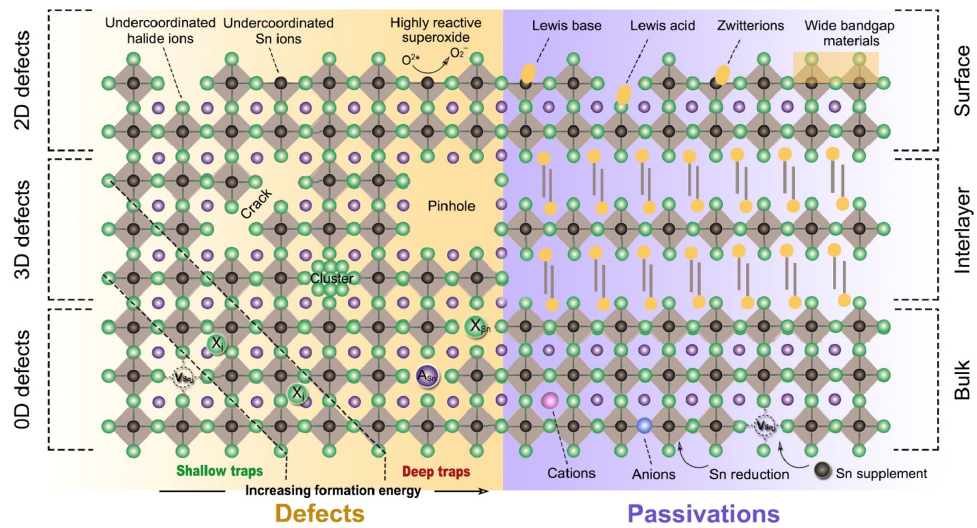
Figure 8. Possible defect states and passivation strategy in Sn-PVK films. Reprinted with permis- sion [46]. Copyright 2020, American Chemical